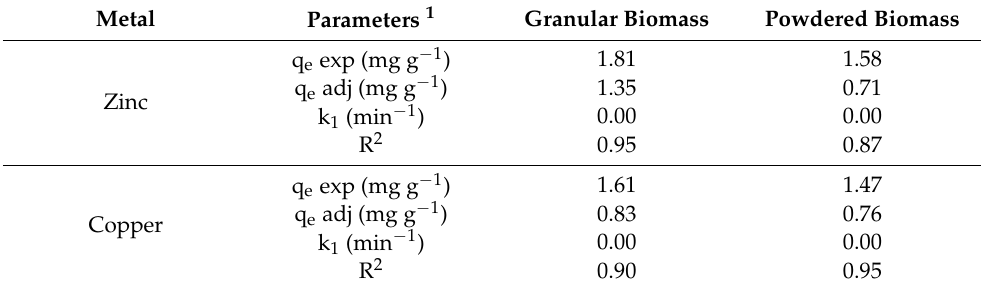
Table 2. Parameters of the pseudo-first-order kinetic model.